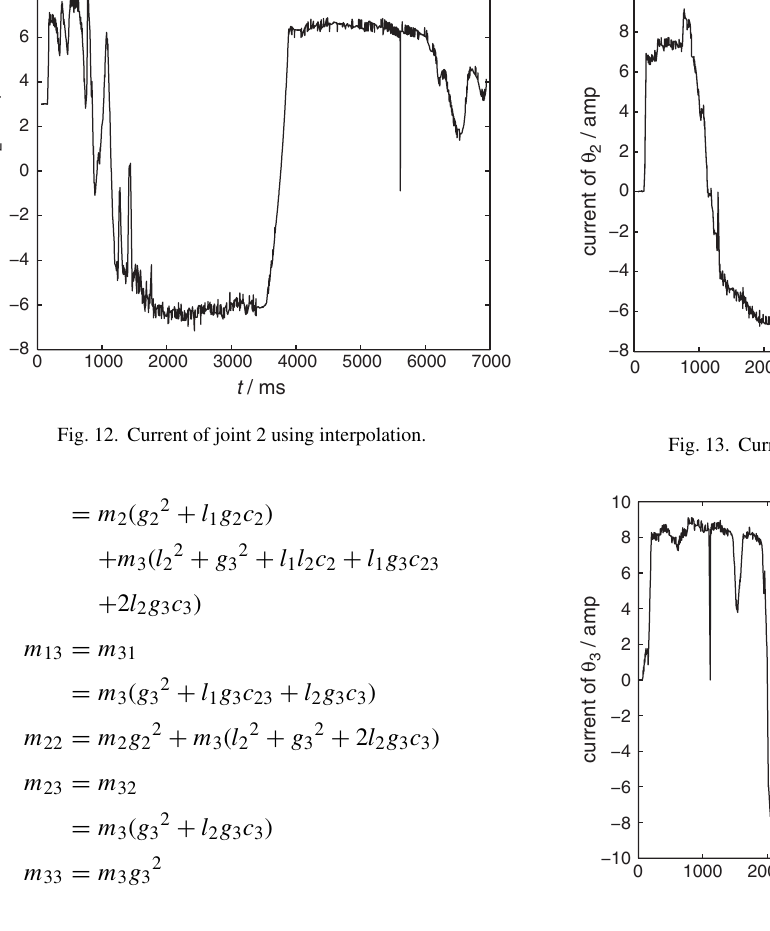
Fig. 14. Current of joint 3 using interpolation.